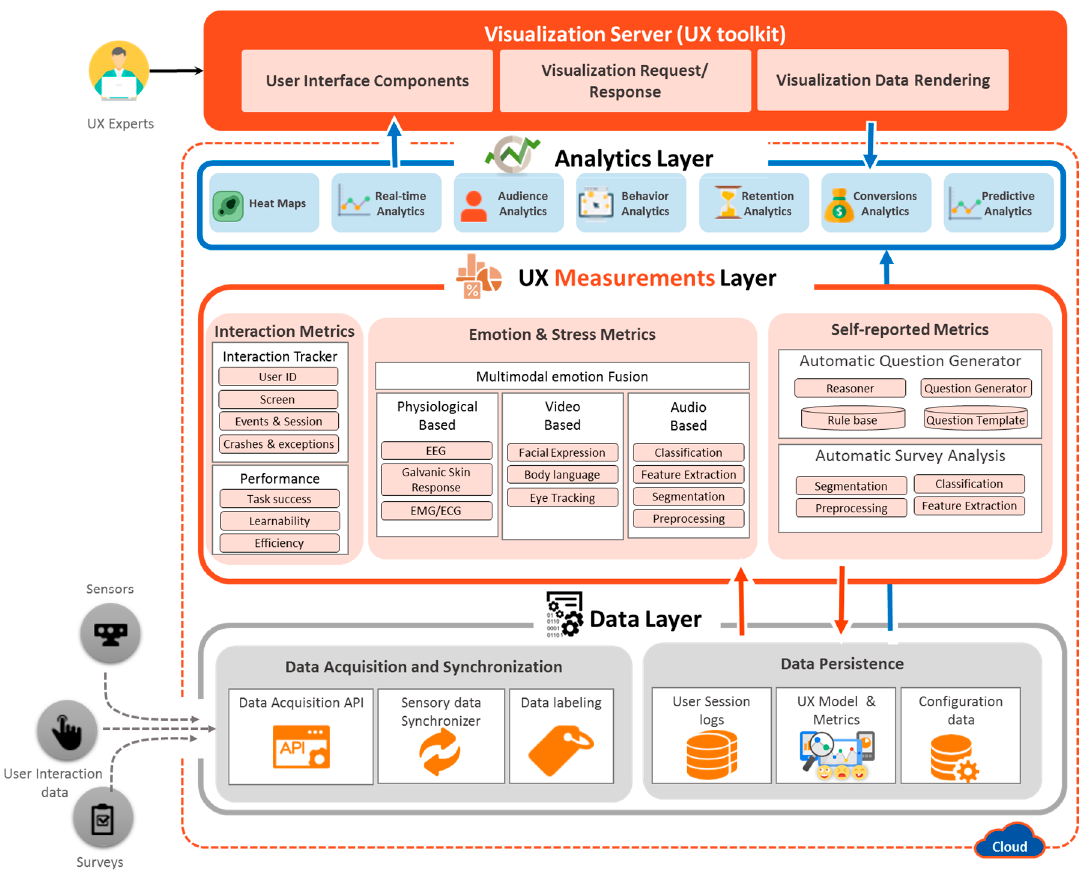
Figure 3. Lean UX platform architecture.